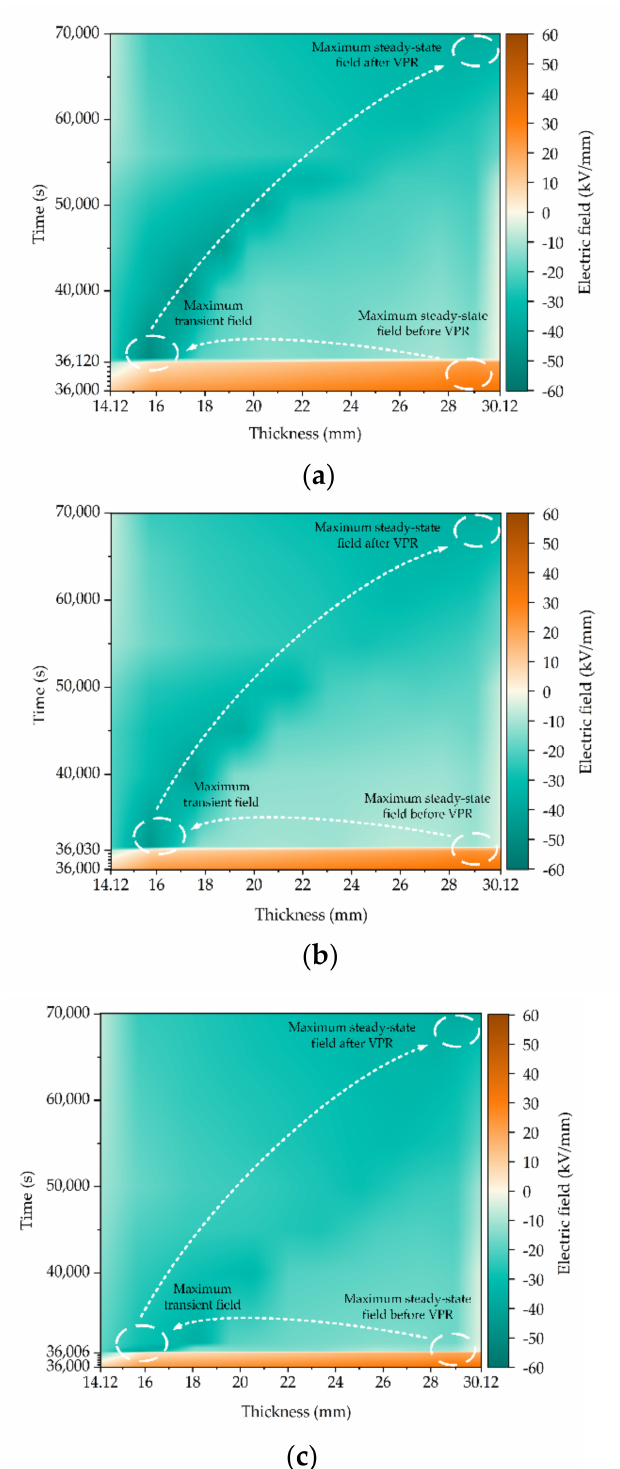
layer, the left vertical axis is the polarization time, and the right vertical axis is the field strength. The time scale ranges from 36,000 s to 70,000 s.